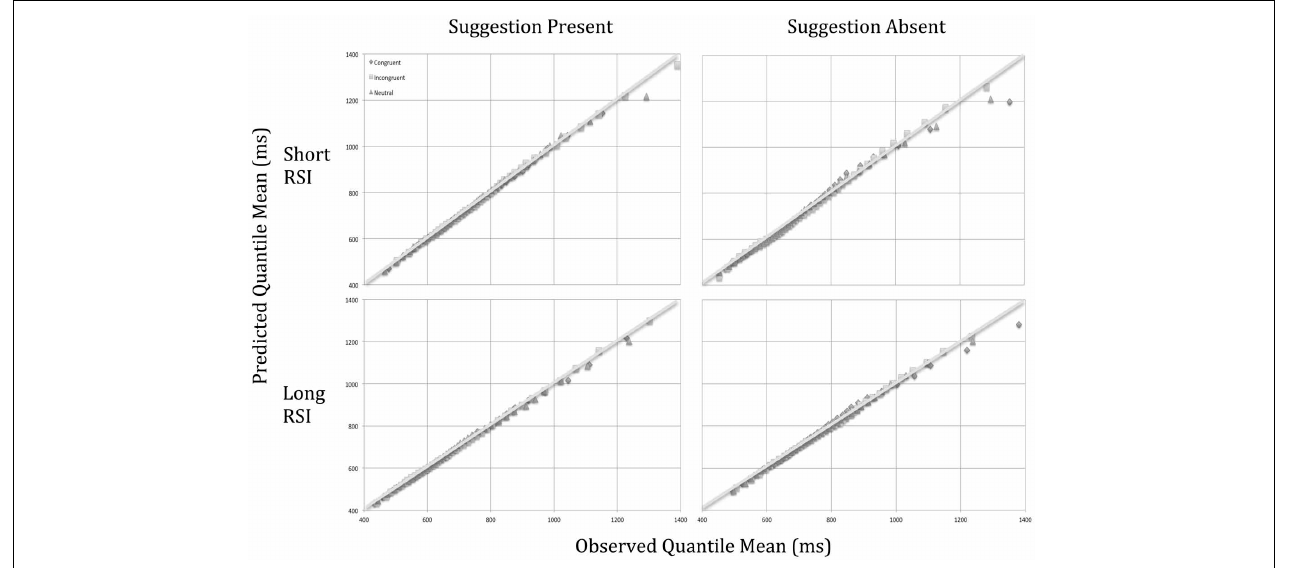
FIGURE 2 | Q-Q Plots showing goodness-of-fit for the estimated values of the ex-Gaussian